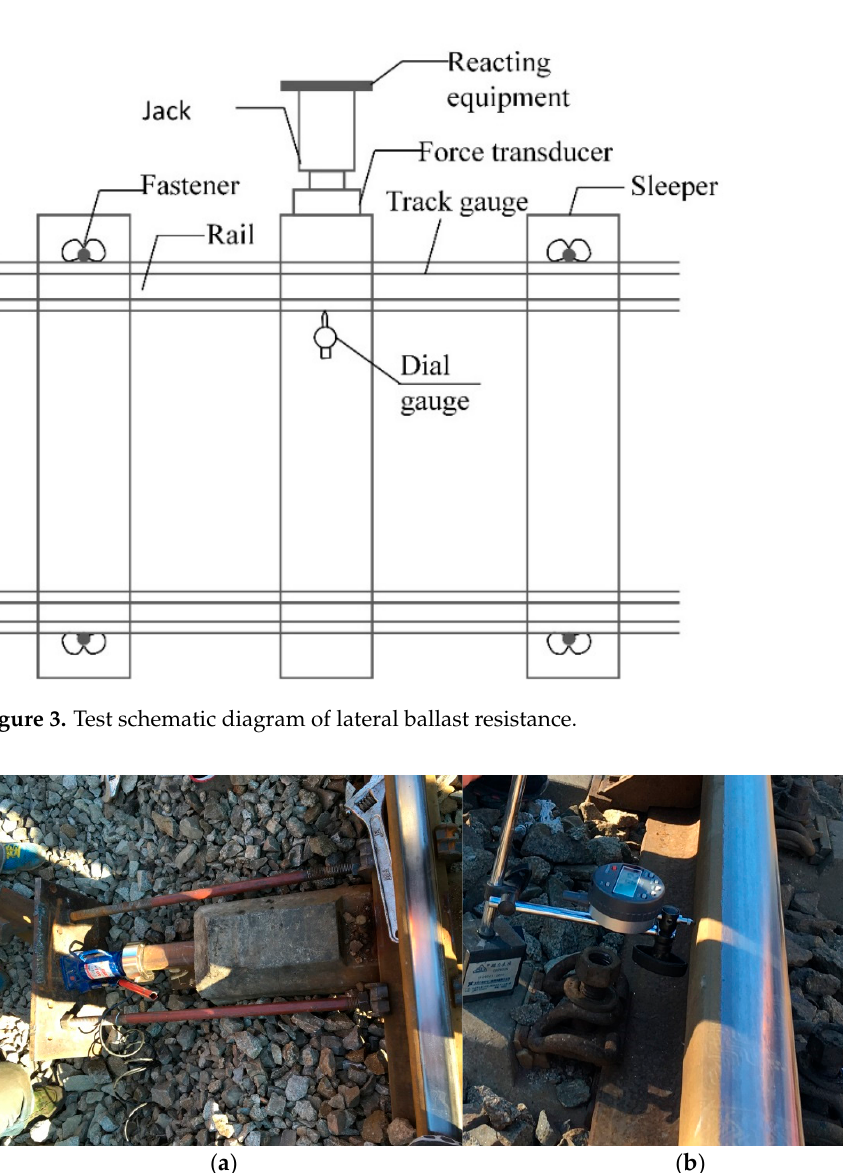
Figure 4. Field tests of lateral ballast resistance. ( a ) Forcing device; ( b ) Displacement measured by a dial gauge.